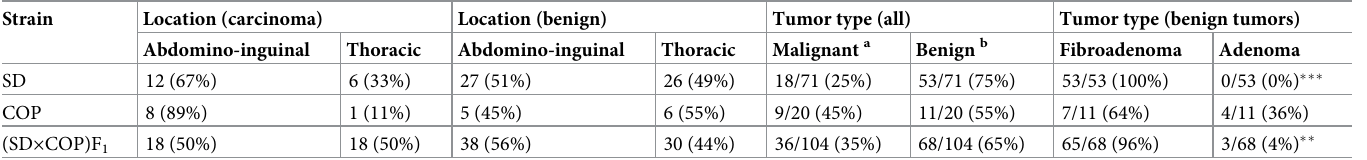
Table 2. Distribution of tumor location and type.